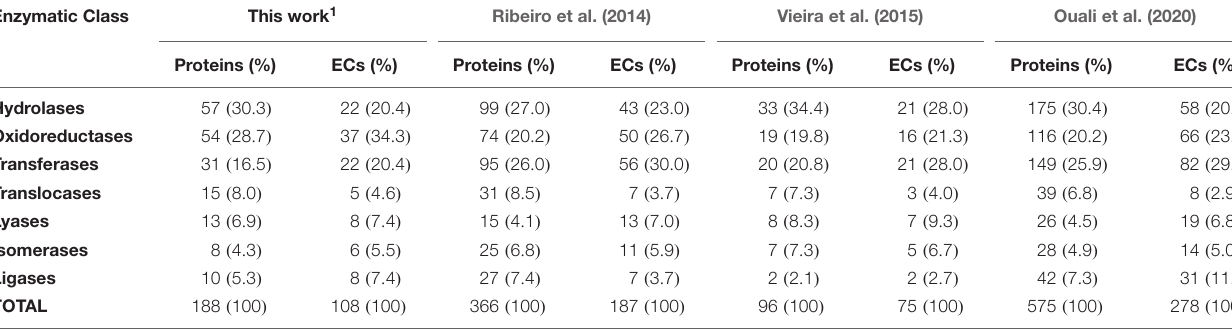
TABLE 2 | Number of proteins and complete ECs distributed by enzyme